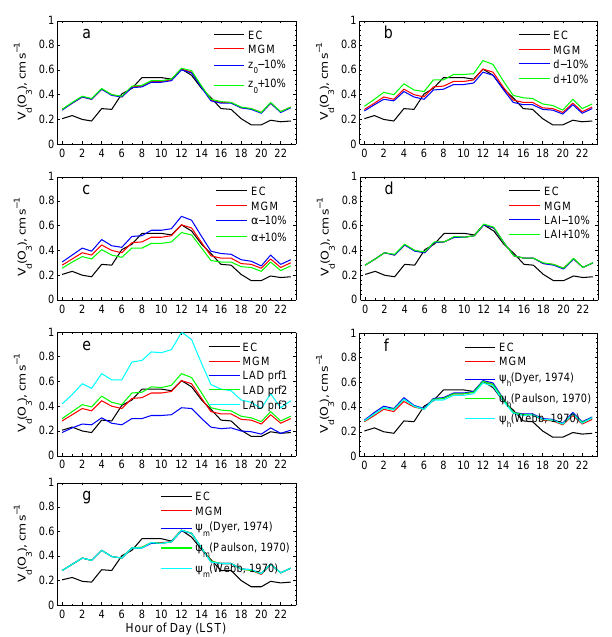
Figure 6. Diurnal average cycles of V d ( O 3 ) over Harvard Forest during 1993–2000 by the modified gradient method (MGM) with different parameter/formula changes and compared with that by the eddy-covariance (EC) technique: (a) roughness length, (b) displace- ment height, (c) wind speed attenuation coefficient, (d) leaf area in- dex, (e) vertical profile of leaf area density, (f) stability correction functions for heat, and (g) stability correction functions for momen-